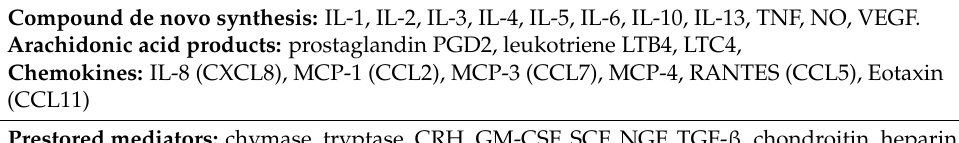
Table 1. Compounds Released by Mast Cells after